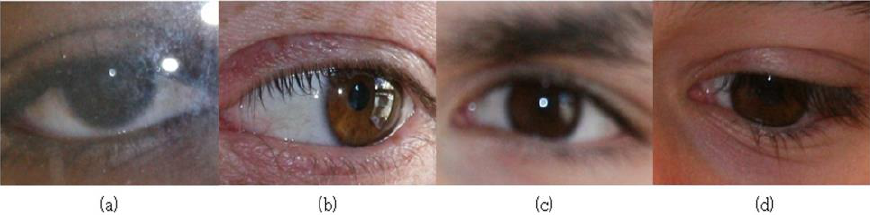
Figure 1. Examples of Noisy Iris Challenge Evaluation-Part II (NICE.II) training dataset. ( a ) Noises by glasses; ( b ) off-angle view and occlusion by ghost area in the right iris region; ( c ) low illumination and blurring; ( d ) occlusion by eyelids and eyelashes.